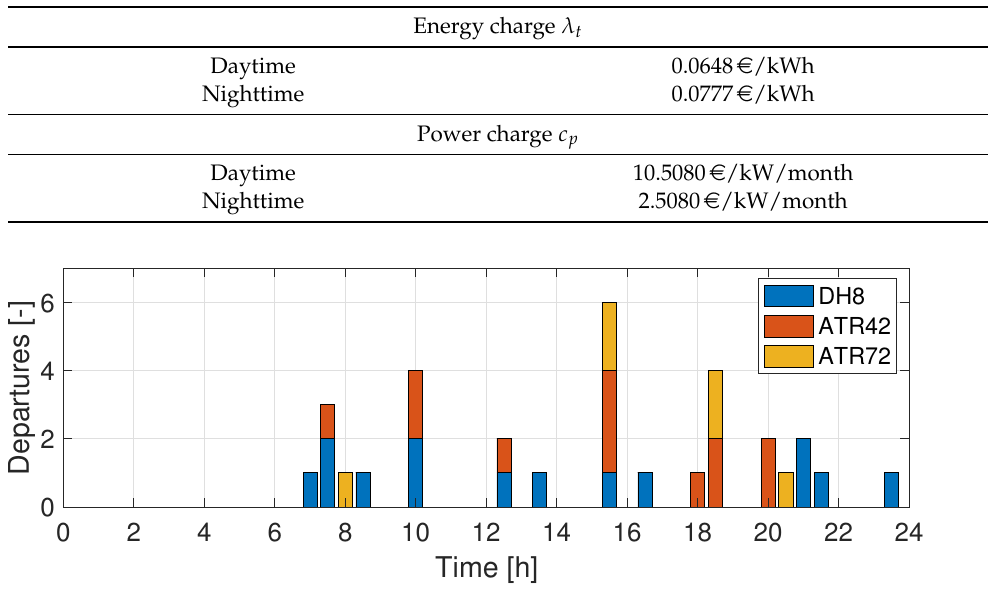
Table 10. Electricity prices employed for LGAV reconfiguration.